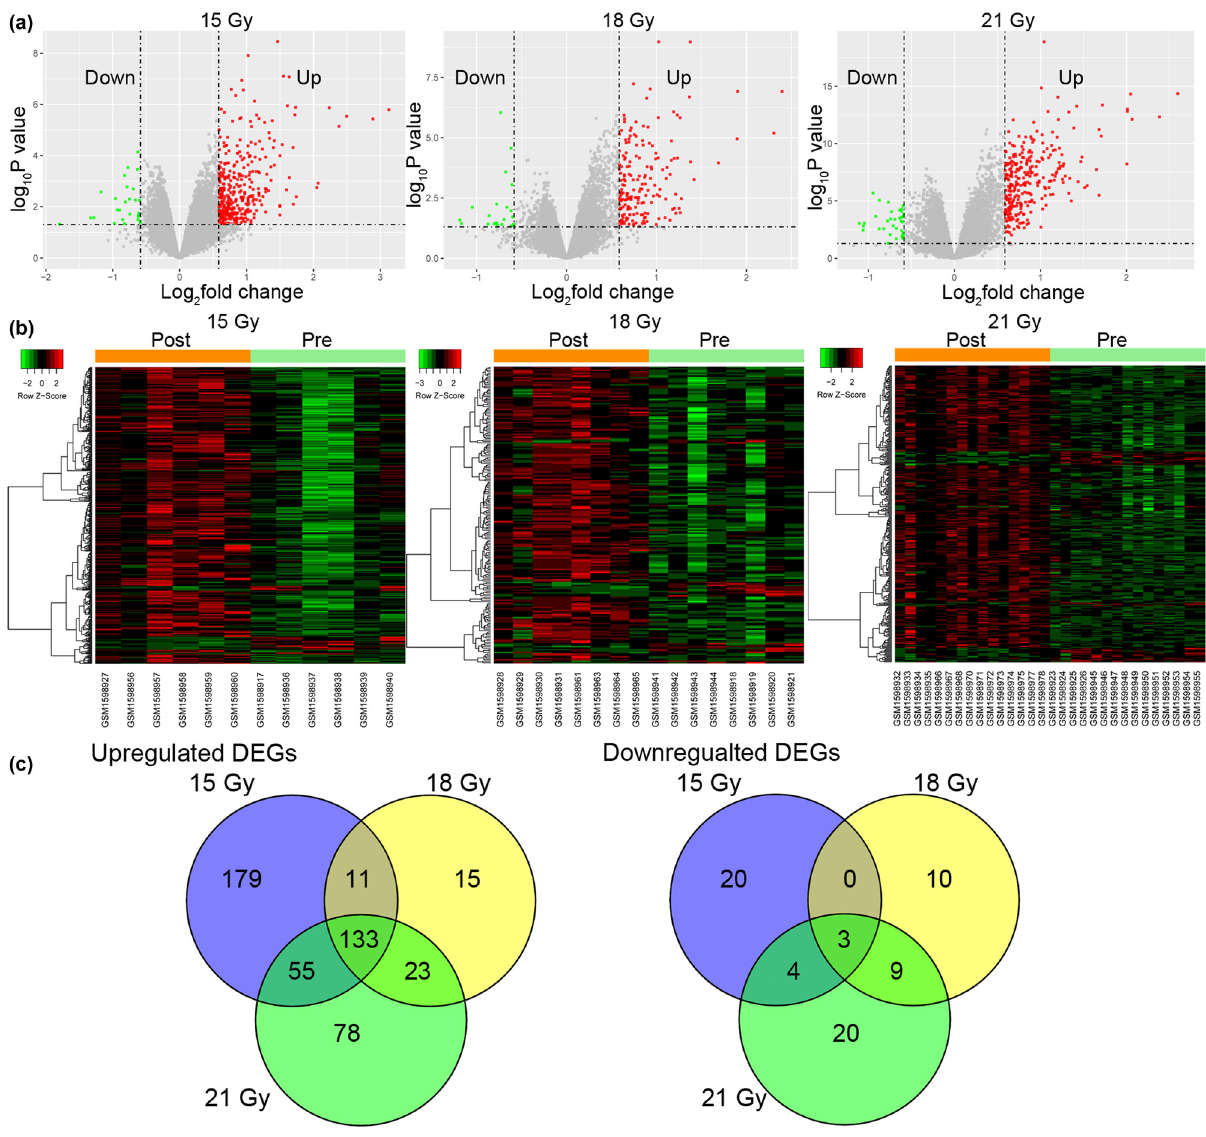
Figure 1: The statistics and clustering of the DEGs in BCa preradiation and postradiation: ( a ) the volcano plot of the DEGs in BCa samples between preradiotherapy and postradiotherapy ( 15 Gy, 18 Gy, and 21 Gy ) , ( b ) the hierarchical clustering analysis of DEGs, and ( c ) the Venn diagram of the upregulated and downregulated radiation - associated genes in BCa in the GSE65505